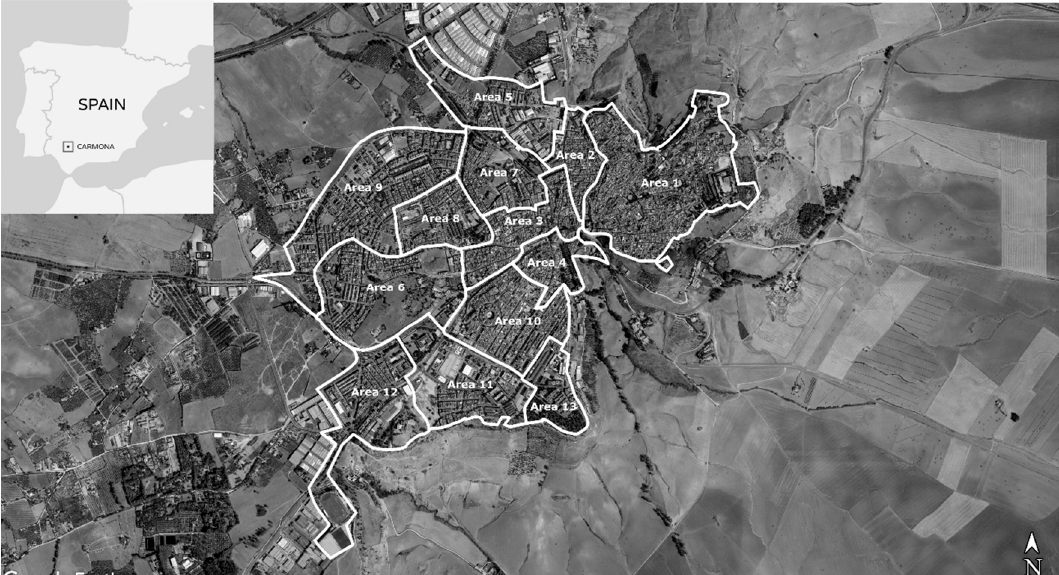
Figure 1. Map of the town of Carmona (Andalusia, Spain) divided into 13 homogeneous areas. Source: Prepared by authors.